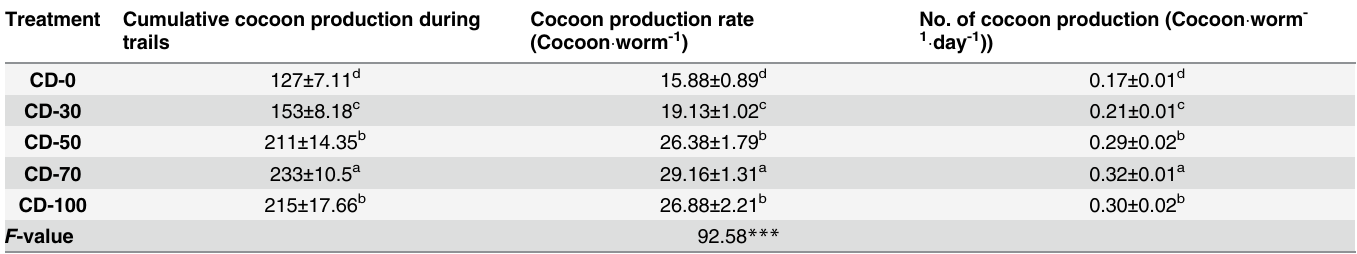
Table 4. Reproduction of Eisenia fetida in different waste mixtures (mean ± S.D, n = 6). Treatment Cumulative cocoon production during